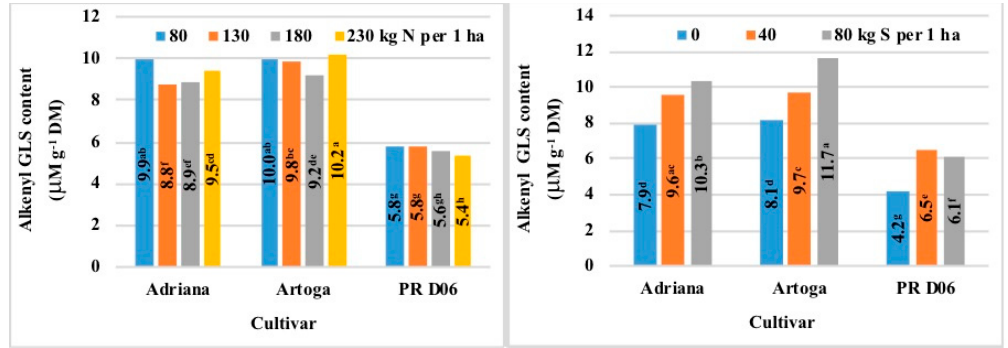
Figure 15. The e ff ect of N and S rates on the content of alkenyl GLS in winter oilseed rape seeds, across